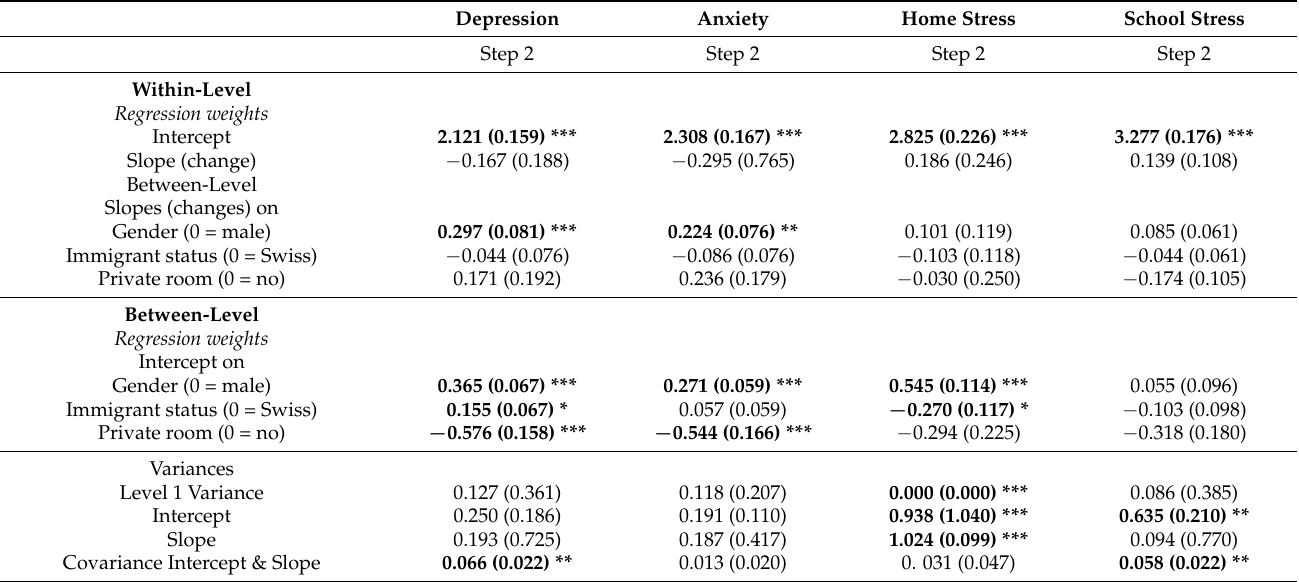
Table 2. Multilevel models (random-slopes-and-random-intercepts models) predicting the changes and mean scores of students’